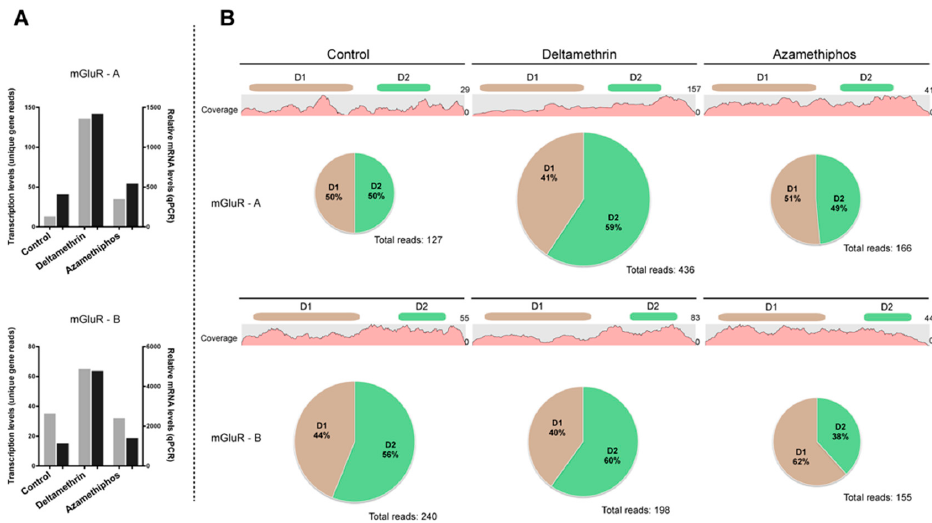
Figure 6. Expression levels of two mGluR genes in Caligus rogercresseyi treated with delousing drugs. ( A ) Validation of gene transcription levels by qPCR analyses. Gray bars correspond to expression changes obtained by in silico analysis, and black bars expression levels inferred by qPCR reactions; ( B ) Distribution of mapped reads in both mGluR transcripts after exposure to deltamethrin or azamethiphos. D1: metabotropic glutamate receptor domain 1; and D2: 7 transmembrane sweet-taste receptor of 3 GPCR.